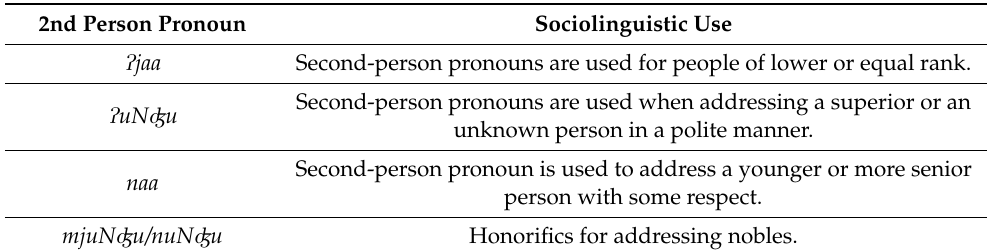
Table 2. Honorification of second person pronouns (Kokuritsu Kokugo Kenky¯ujo